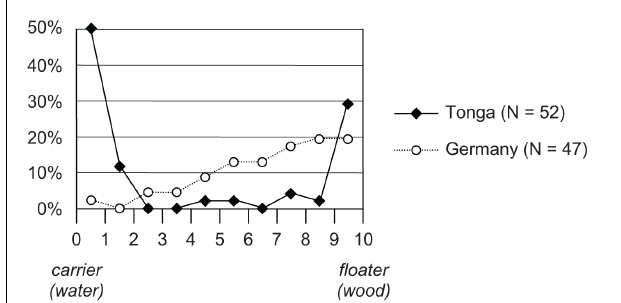
FIGURE 3 | Distribution of the causal assignments in setting B with the analog rating format (in decentiles), pooled across the two agency conditions.